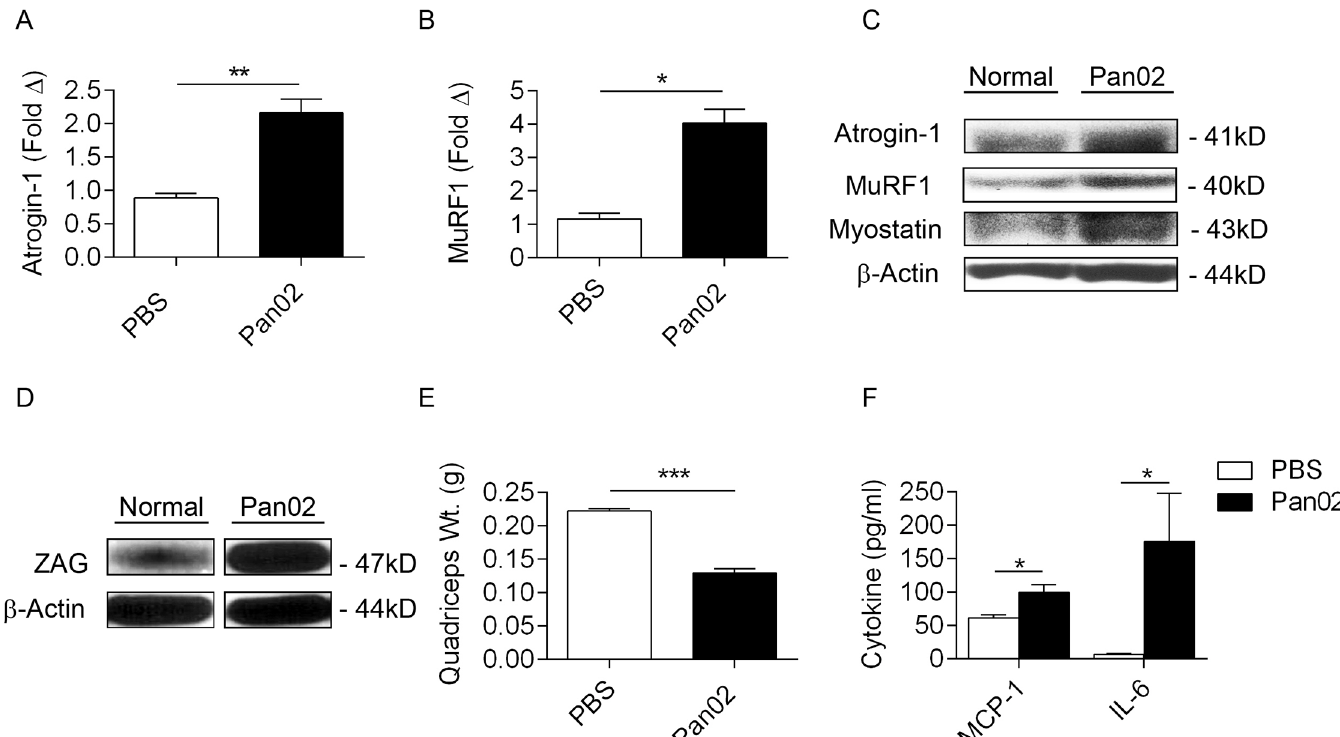
Fig 3. Evidence of muscle wasting and systemic inflammation. (A) mRNA levels of Atrogin-1 and (B) MuRF1 in quadriceps muscles of mice treated with PBS or Pan02 were calculated by qPCR. (C) Similarly, levels of Atrogin-1, Myostatin, MuRF1, and β -actin in quadriceps muscle were calculated by Western blotting. (D) ZAG expression was tested in visceral adipose tissue from cohorts of mice treated with either PBS or Pan02. (E) Weight of quadriceps muscles from mouse cohorts treated with PBS or Pan02 was calculated. (F) Serum levels of MCP-1 and IL-6 were compared in PBS- and Pan02-treated mice (n = 5; * p < 0.05, ** p < 0.01, *** p < 0.001).